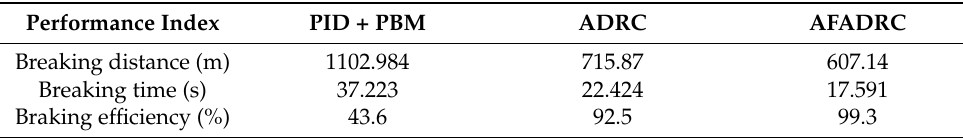
Figure 8. Case 2 simulation results: ( a ) aircraft velocity and wheel velocity; ( b ) breaking distance; ( c ) slip ratio; ( d ) AESO parameters; ( e ) control input; ( f ) extended state. Table 10. AABS performance index in Case